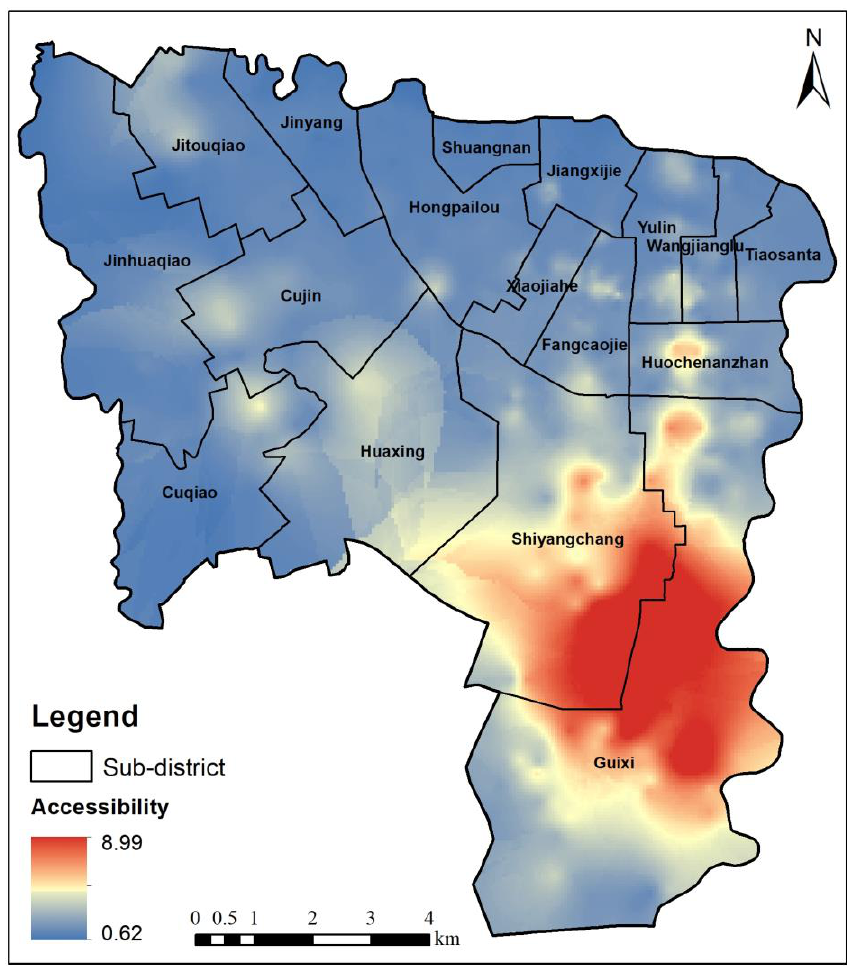
Figure 6. Park spatial accessibility based on SCM-G2SFCA model.